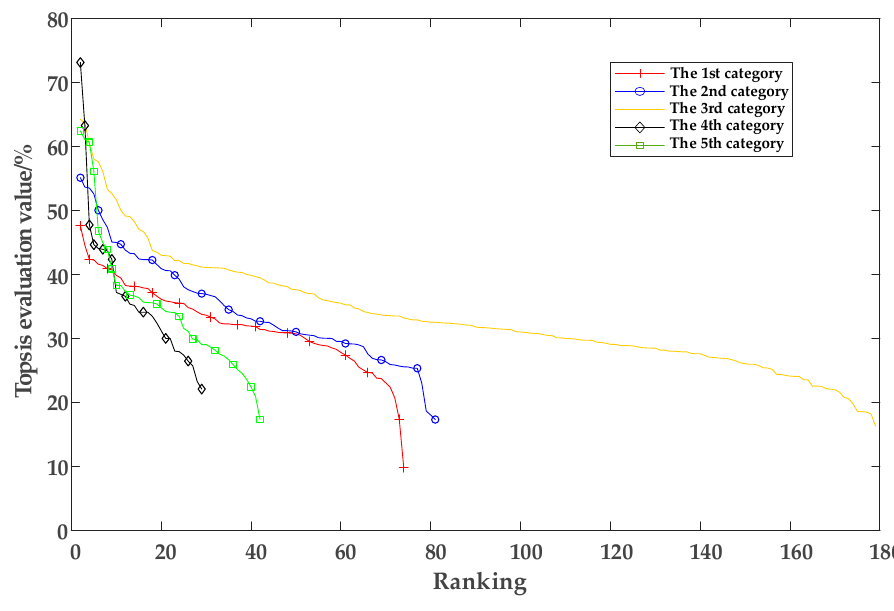
Figure 11. TOPSIS evaluation result trend.